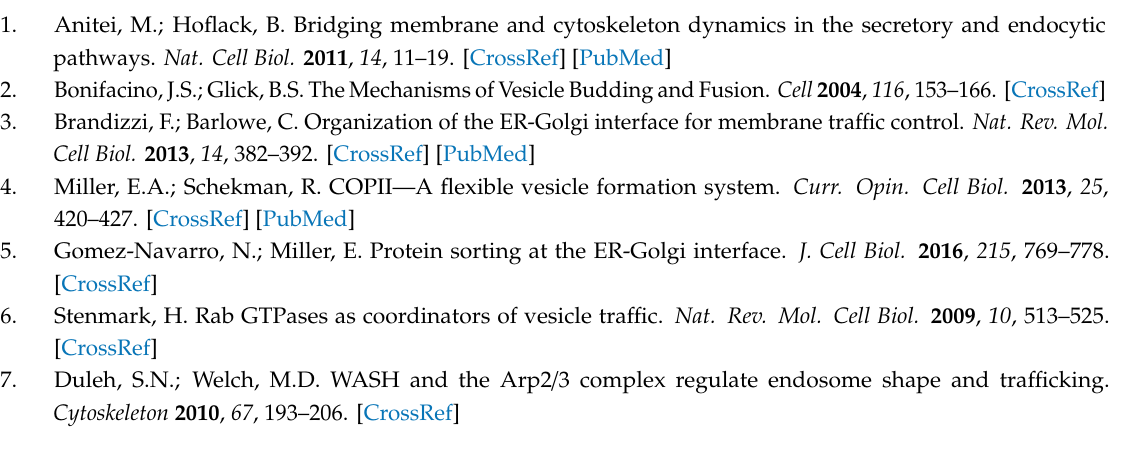
Figure S1: Polar distribution score analysis method, Figure S2: E ff ect of siRNA-mediated depletions on total Golgi area, Figure S3: Validation of the e ffi ciency of siRNA depletions by real-time qPCR, Figure S4: Validation of siRNA-mediated depletion of RhoBTB3 and Cdc42 by western blotting, Figure S5: RhoBTB1 is important for early endosome morphology, Figure S6: RhoBTB1 depletion has no e ff ect on EEA1, LAMP1 and Rab5 mRNA levels, Table S1: siRNA library used, Video S1: Live cell imaging of HeLa cell stably expressing p24-YFP and treated with non-silencing NEG control siRNA, Video S2: Live cell imaging of HeLa cell stably expressing p24-YFP and treated with siRNA targeting Cdc42, Video S3: Live cell imaging of HeLa cell stably expressing p24-YFP and treated with siRNA targeting